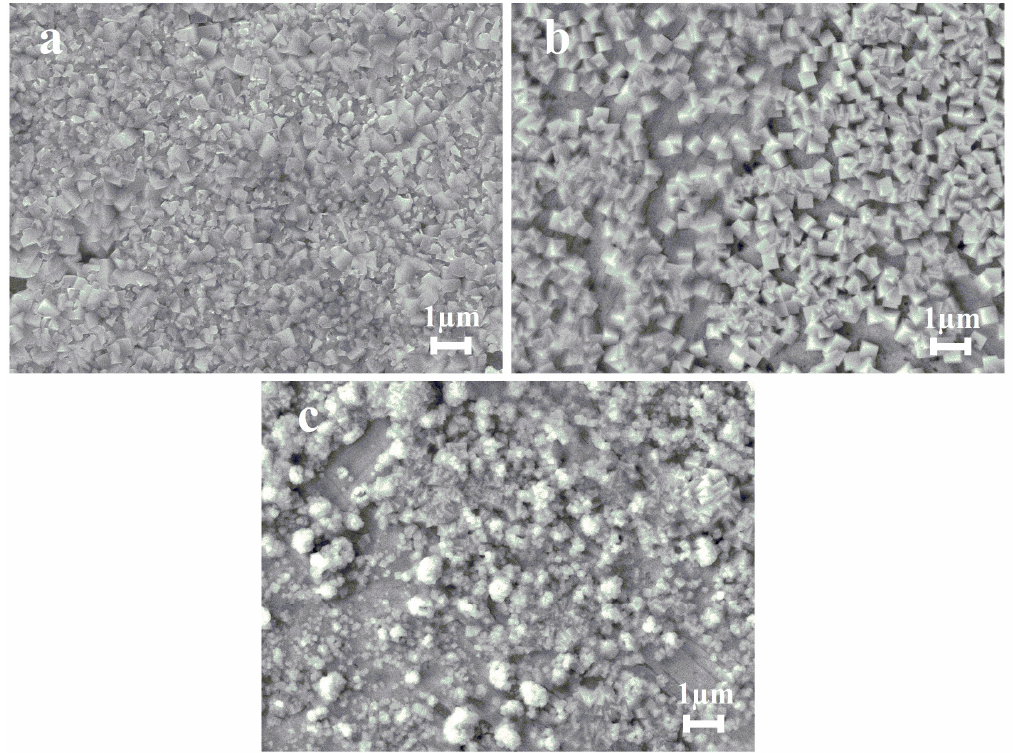
Figure 6. SEM images of the synthesized copper particles obtained for 7.5 min at a current density of − 3 A m − 2 ( a ), − 5 A m − 2 ( b ), − 15 A m − 2 ( c ).